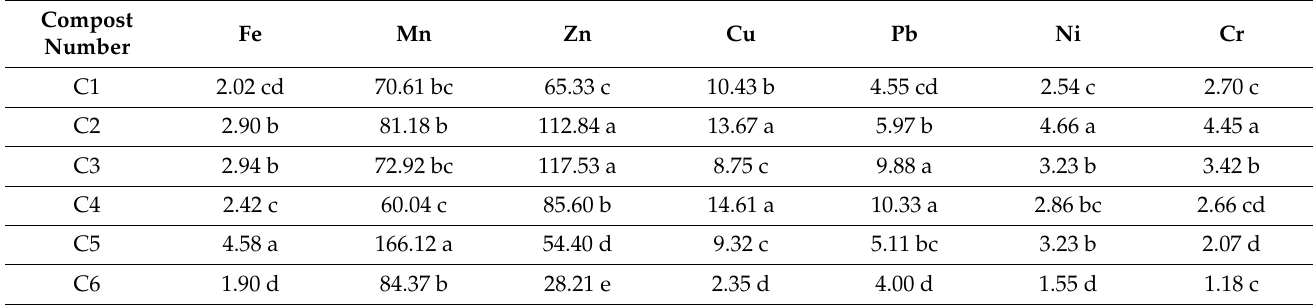
Table 6. Bioavailable amounts of metals in composts (mg · kg − 1 , except Fe expressed in g · kg − 1